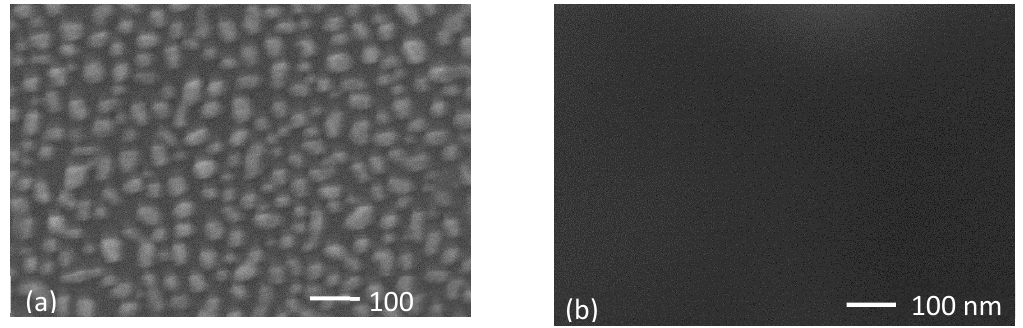
Figure 6. Comparison of SEM micrographs ( a ) Ag film of 6 nm, ( b ) Ag:Al film of 7.1 nm films. Al doping reduces the clustering and aids to form more continuous films.